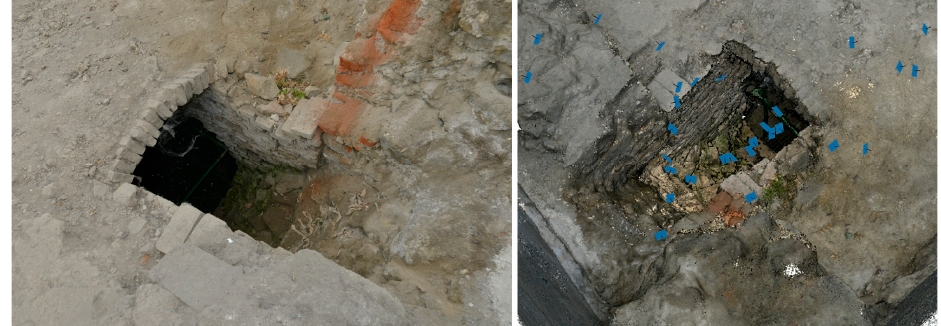
Figure 5. Opening no. 2 ( left ), and the positions of the cameras in the connecting image strip ( right ).